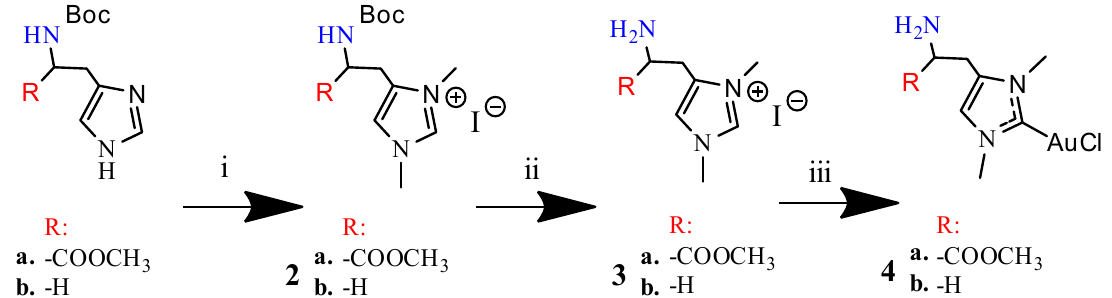
Figure 1. Strategy for the synthesis of conjugates.